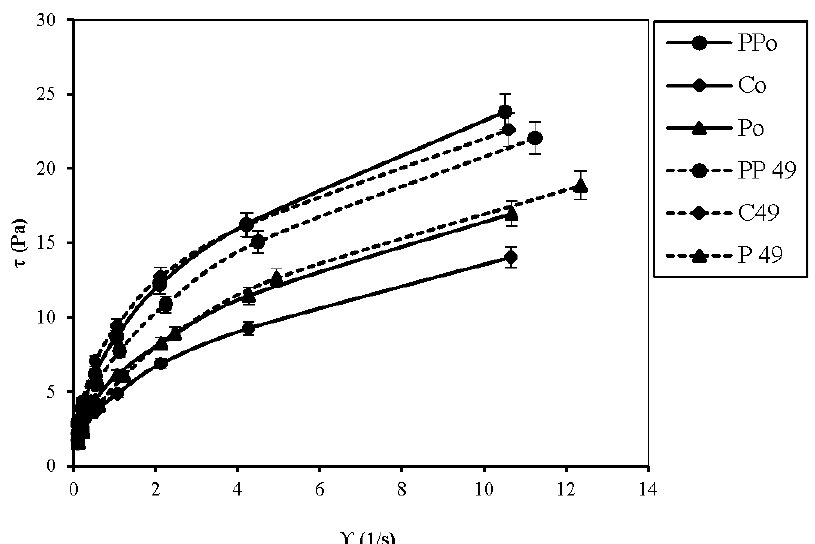
Figure 2. The plots of average shear stress vs. average shear rate for three oatmeal-coconut water matrices on the production date (Day 0) and on the expiration date (Day 49).